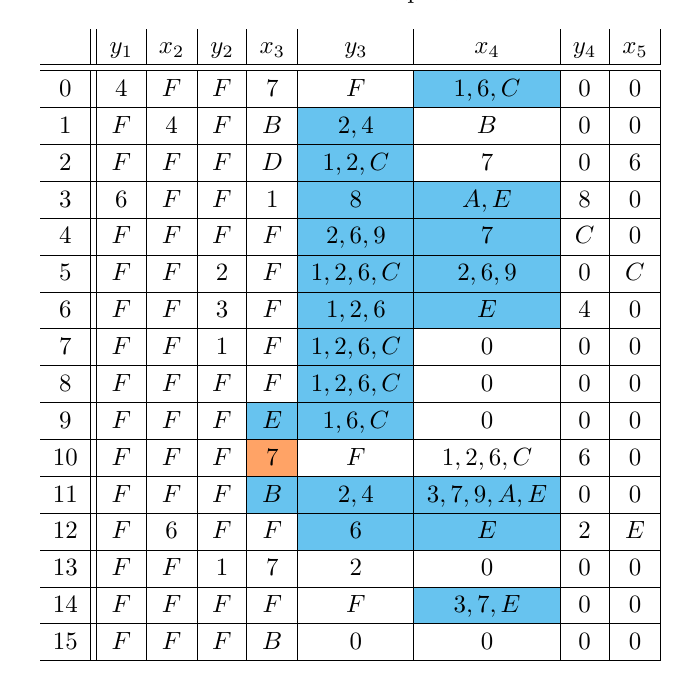
Table 3: Internal state at Step s + 1 - first branch